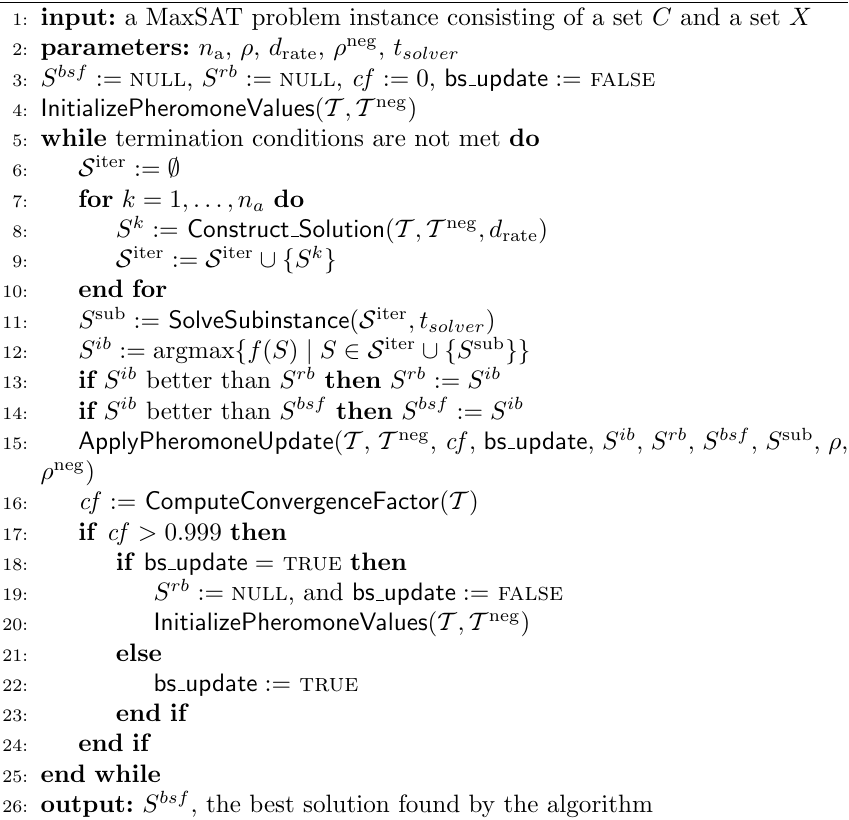
Algorithm 1 Negative Learning Aco for unweighted